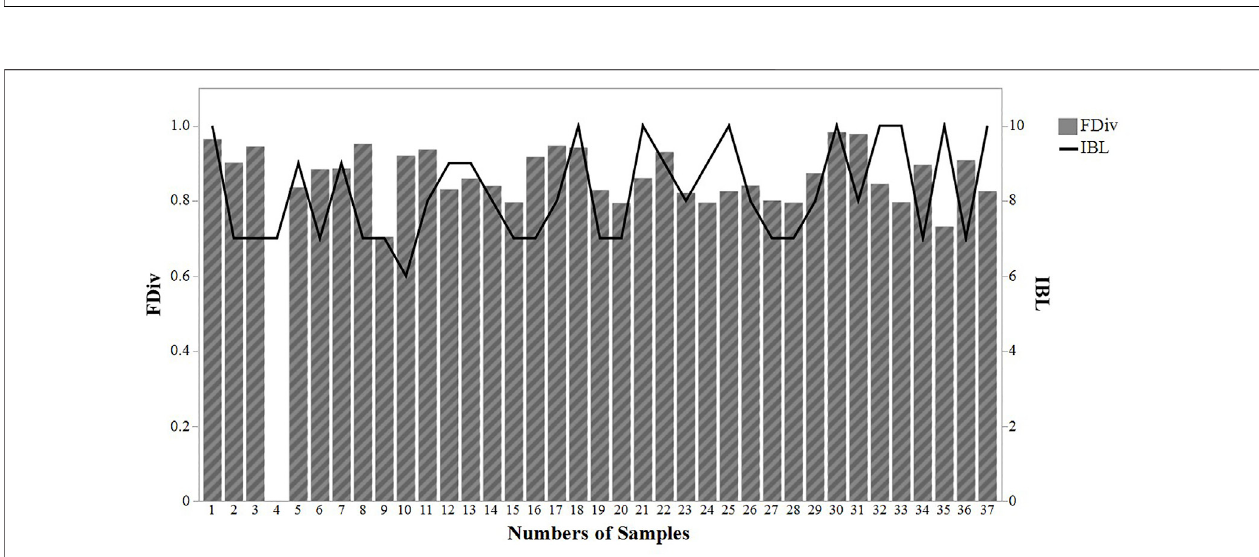
FIGURE 5 | Comparison between functional divergence (FDVi) and sludge biotic index (IBL) values throughout 37 samplings in a wastewater treatment plant in Brazil.